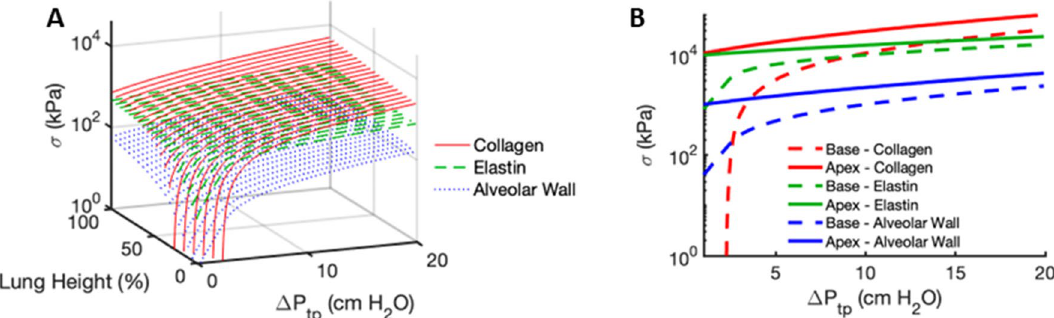
Figure 8. Prediction of the regional circumferential stresses in the alveolar septal walls, on elastin fibers and collagen fibrils. ( A ) 3D plot of the wall stress (blue dotted), elastin stress (green dashed) and collagen stress (red solid) as a function of transpulmonary pressure change above FRC and on height in the lung. ( B ) 2D plot of the same stresses shown only for the base (dashed line) and apex (solid